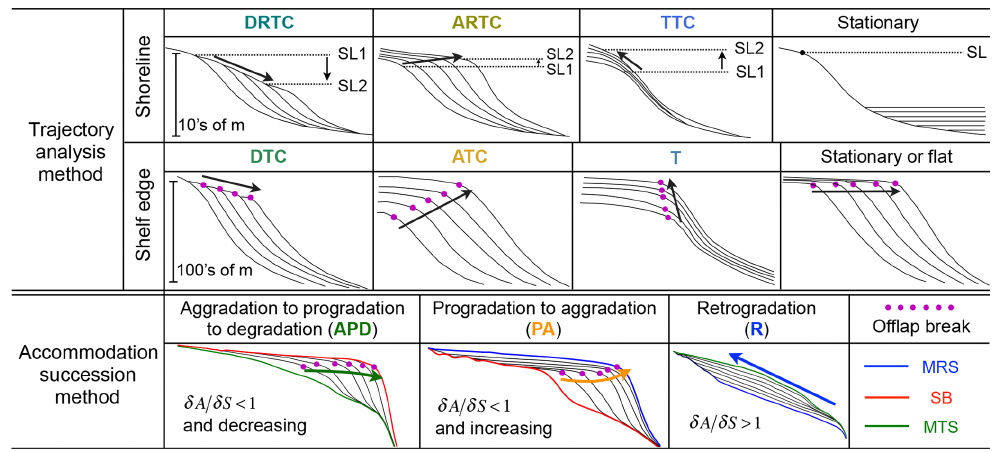
Figure 2. Stratigraphic sequence interpretation approaches used in this study. In the trajectory analysis method, four shoreline trajectory classes and three shelf-edge trajectory classes are delineated based on the lateral and vertical migrations of shoreline and shelf edge. The shoreline trajectory classes include descending regressive trajectory class (DRTC), ascending regressive trajectory class (ARTC), transgres- sive trajectory class (TTC) and stationary trajectory class. The shelf-edge trajectory classes include descending (DTC), ascending (ATC), transgressive (T) and stationary shelf-edge trajectory classes (Helland-Hansen and Gjelberg, 1994; Helland-Hansen and Martinsen, 1996; Helland-Hansen and Hampson, 2009). In the accommodation succession method, three types of stacking patterns and their bounding surfaces are defined based on observations of stratal terminations (e.g. onlap, offlap) and stratal geometries, including aggradation to progradation to degradation (APD) stacking, progradation to aggradation (PA) stacking and retrogradation (R) stacking. The bounding surfaces are sequence boundary (SB), maximum transgressive surface (MTS) and maximum regressive surface (MRS). Each stacking pattern reflects changes in the rate of accommodation creation ( δA ) with respect to the rate of sediment supply ( δS ) at the shoreline. APD stacking corresponds to δA/δS < 1, with a decreasing trend that can be negative; PA stacking represents δA/δS < 1 and increasing; finally, R stacking occurs for δA/δS > 1 (Neal and Abreu, 2009; Neal et al.,